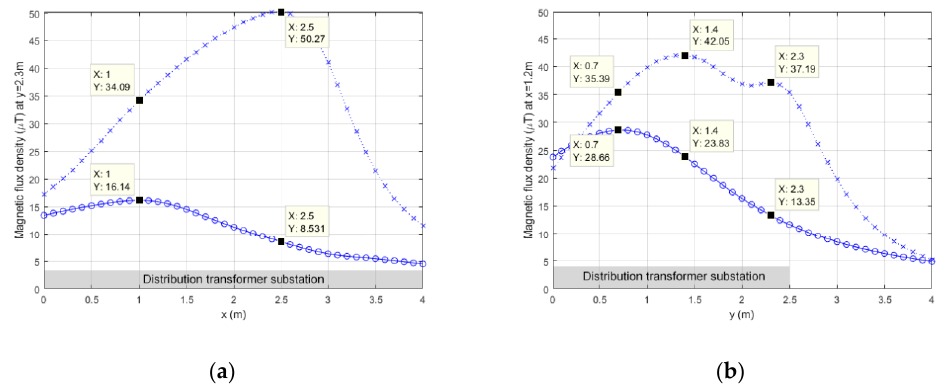
Figure 13. MFD on the upper floor at a height of 20 cm (z=2.9 m), at y=2.3m ( a ), and at x=1.2m ( b ) for the original situation (crosses) and for the proposed alternative (circles). the original situation (crosses) and for the proposed alternative